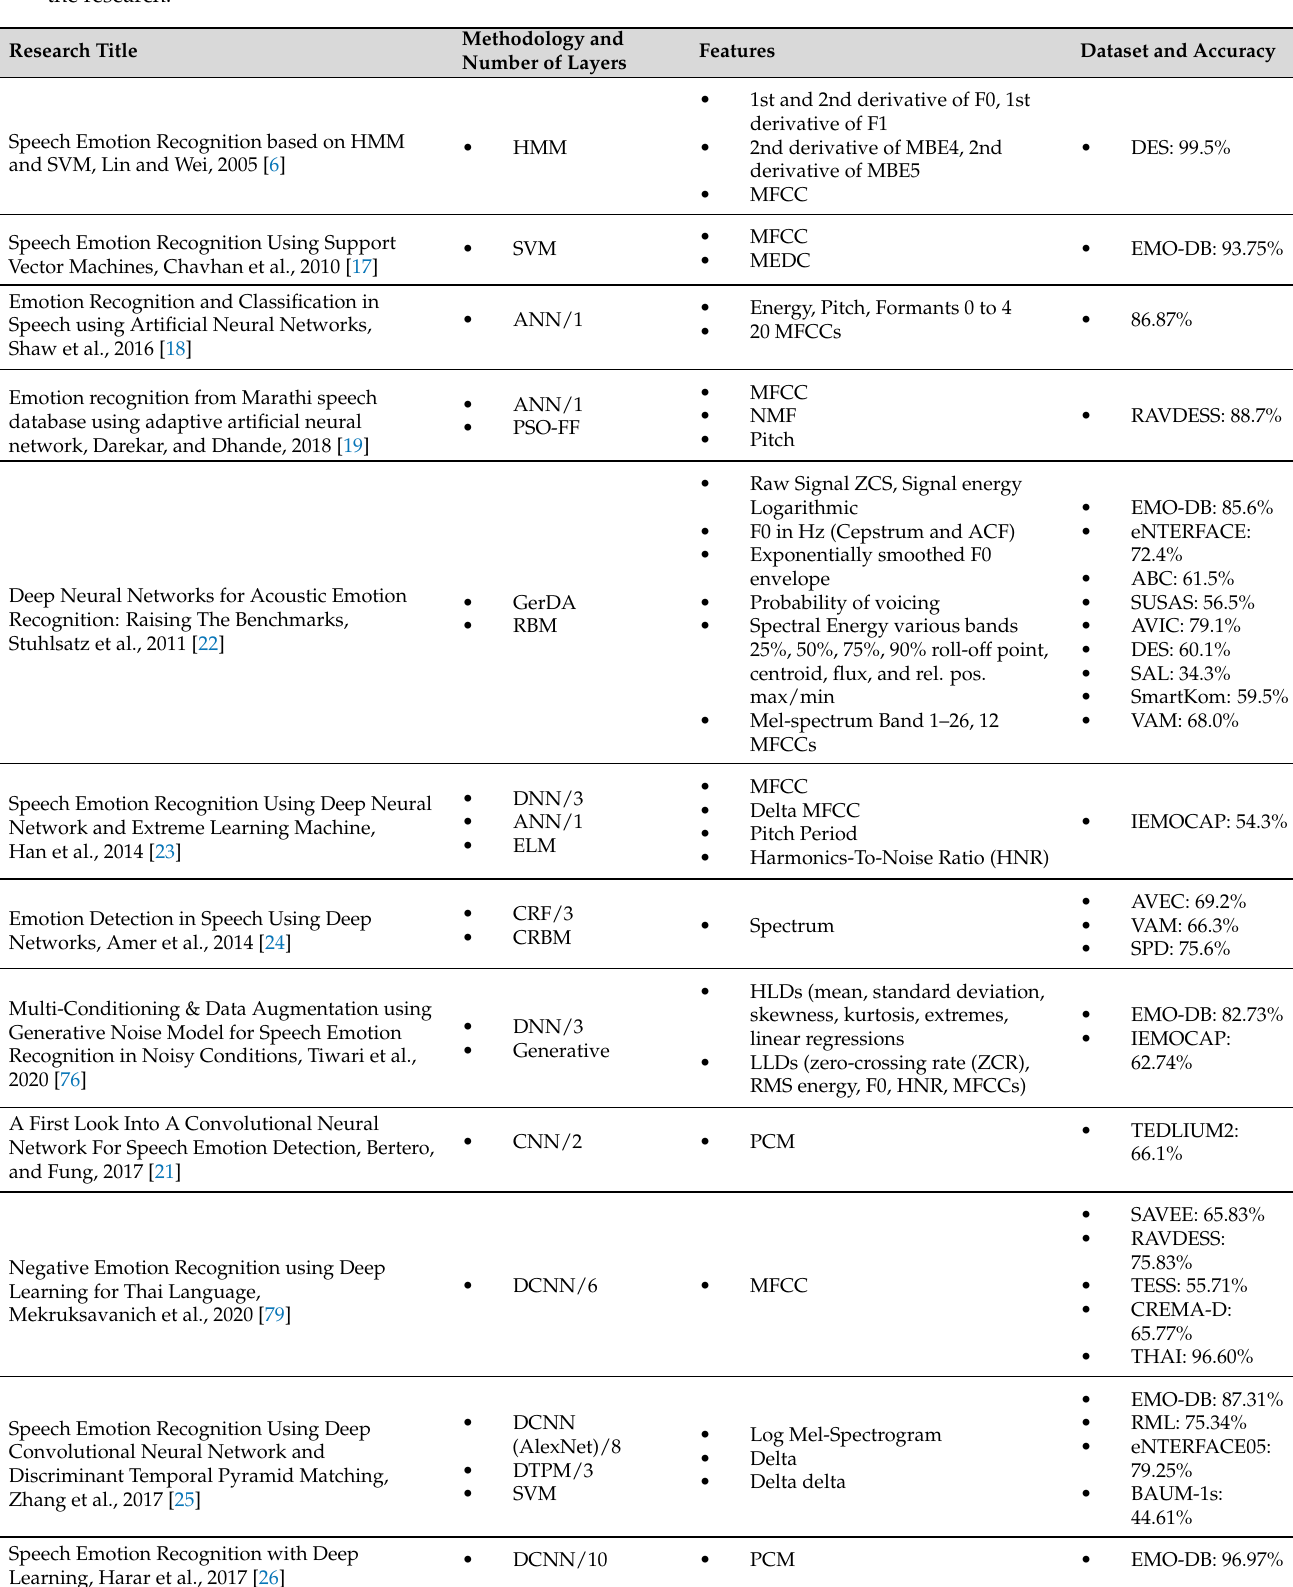
Table 4. A brief comparison of all the algorithms reviewed, containing the highest accuracy reported for each dataset, all the features used to train the system, methods used and if applicable, number of the layers in each method, and the title of the